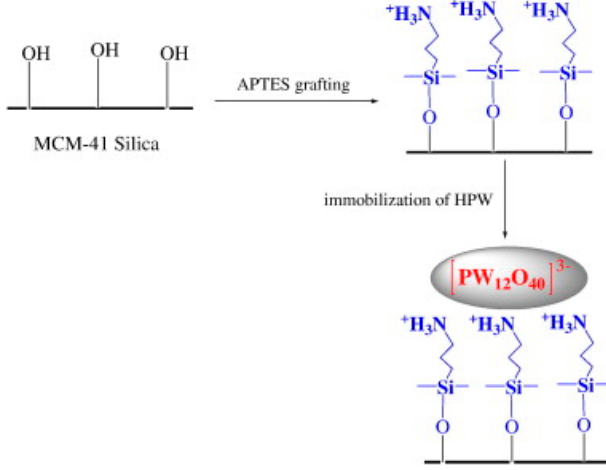
Figure 40 . Schematic procedure for the surface modification of MCM-41 silica and the subsequent immobilization of 12-tungstophosphoric acid (HPW). Reproduced with permission from [76]. Copyright 2010 Elsevier B.V.